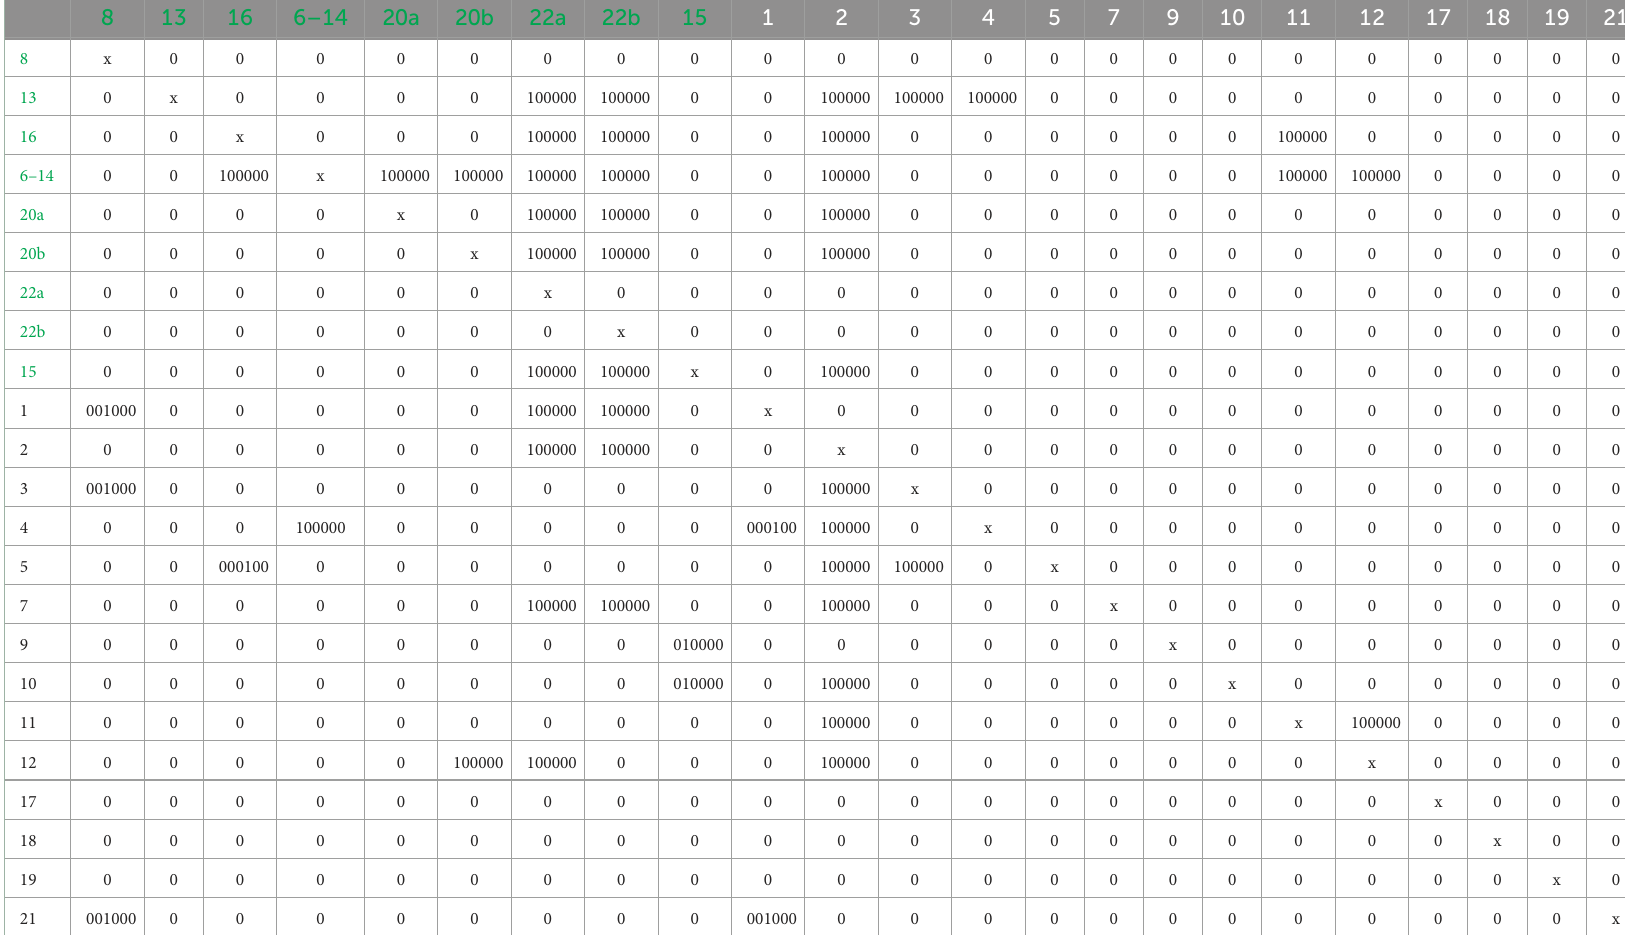
TABLE 2 DPM matrix applied to the BOM components (fasteners in